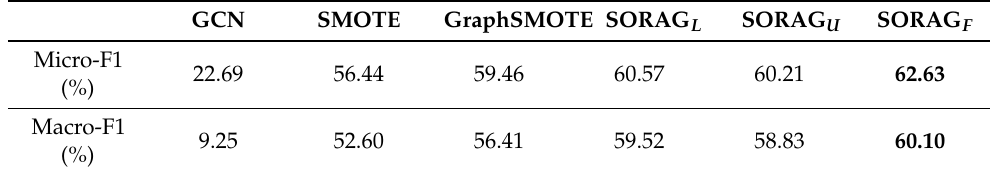
Table 6. Comparison in terms of Micro-F1 and Macro-F1 on US-A IRPORT . The best results are boldfaced. GCN